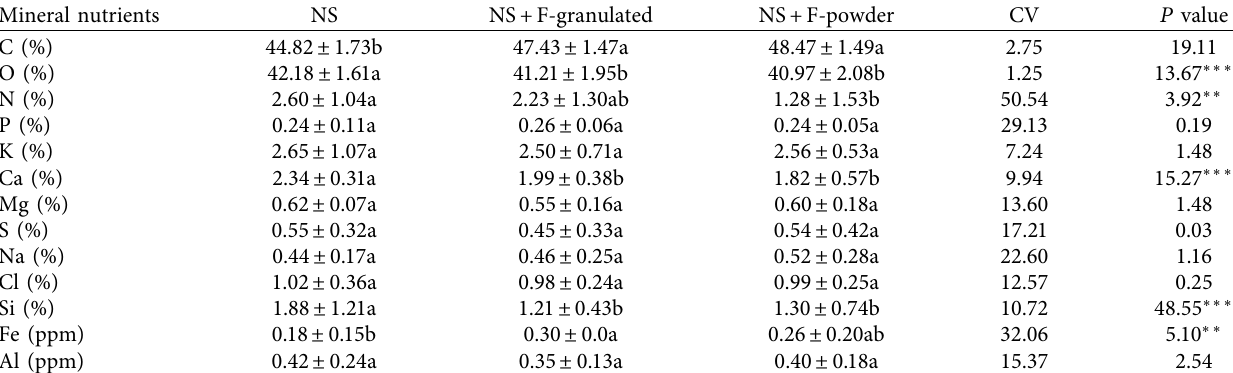
Table 4: Nutrient profile due to the effect of NS and organomineral fertilizer in tomato cherry. Mineral nutrients